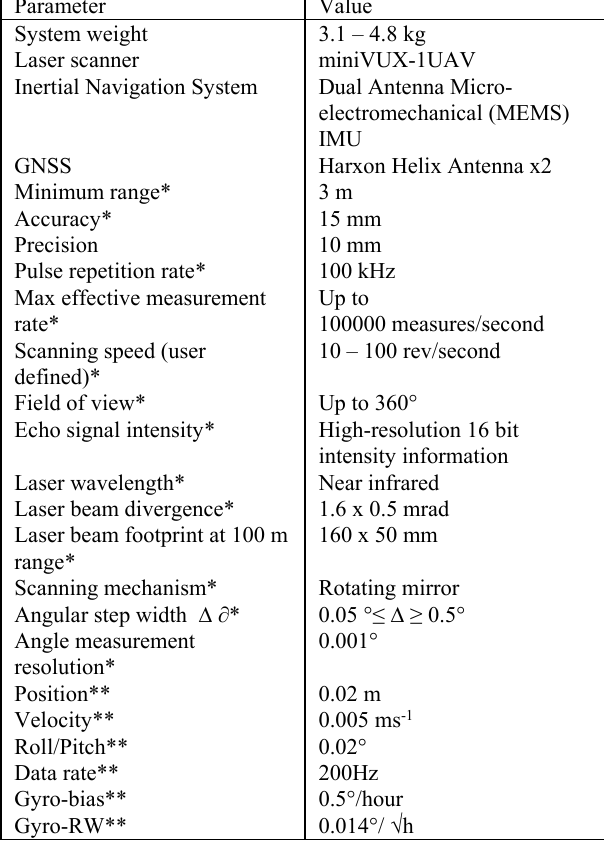
Table 3. Robin Mini specifications. *Mini VUX1-UAV, **MEMS IMU (3D Laser Mapping, 2018; RIEGL Laser Measurement Systems,